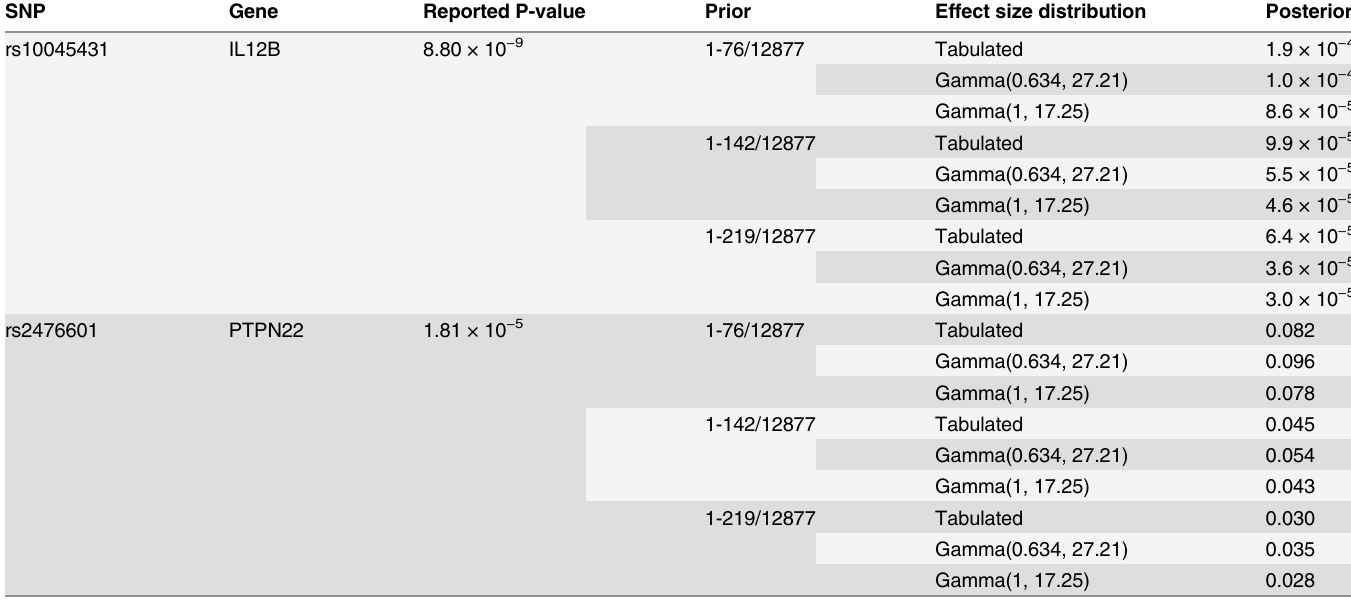
Table 5. Posterior Pr( H 0 j P-value) for two newly identified loci based on the results reported in Barrett et al. [13]. The three prior probabilities are based on the three estimates for the total number of susceptibility SNPs taken from Park et al ’ s. supplementary Table 5. [7] The “ Tabulated ” effect size distri- bution is based on Park et al ’ s supplementary Table 3; “ scale ” in Gamma(1 or 0.634, scale) is chosen to have the distribution mean equal to that of the tabulated distribution. SNP